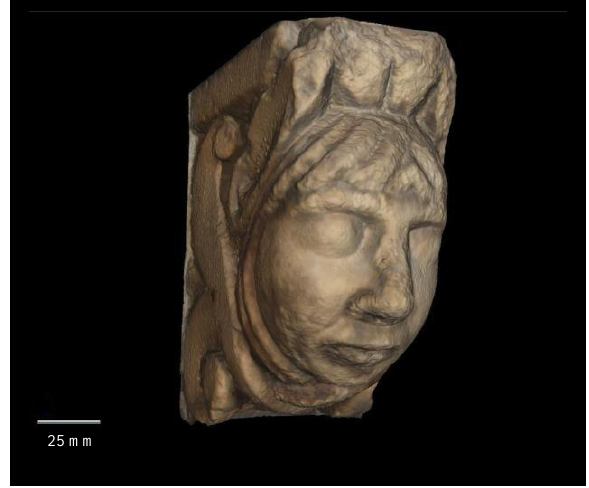
Figure 5. The 3D model of the figure-like corbel, obtained with the image-based approach and constituted by 3,920,000 triangular